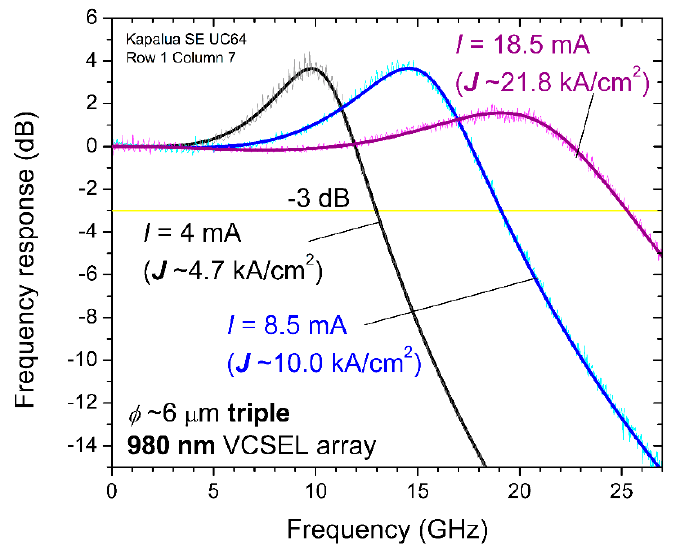
Figure 8. Measured small-signal modulation frequency response (|S21|) for a 980 nm triple VCSEL array with ϕ ~ 6 μ m at direct current (DC) bias currents I = 4, 8.5, and 18.5 mA. Table 1. Extracted |S21| fitting parameters for the Kapalua triple 980 nm VCSEL with φ ~6 µ m. DC Bias